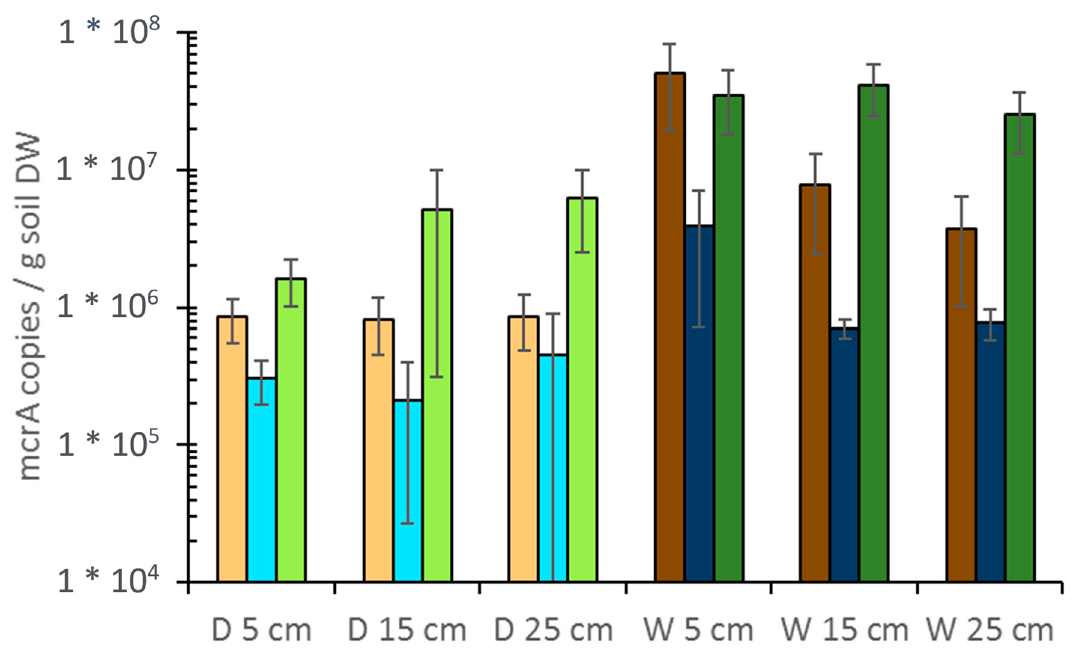
Figure 8. Abundance of methanogens in drained (D) and rewetted (W) peat soils. Depth-resolved quantification of mcrA gene copies / g dry weight (DW). brownish: alder forest, blue: coastal fen, green: percolation fen. Primers used for qPCR: mlas-mod / mcrA-rev [111], DNA extracts were measured in concentrations of 2 ng / µ l and 1 ng / µ l in duplicates. Bars show the average of triplicate cores; error bars show standard deviation of